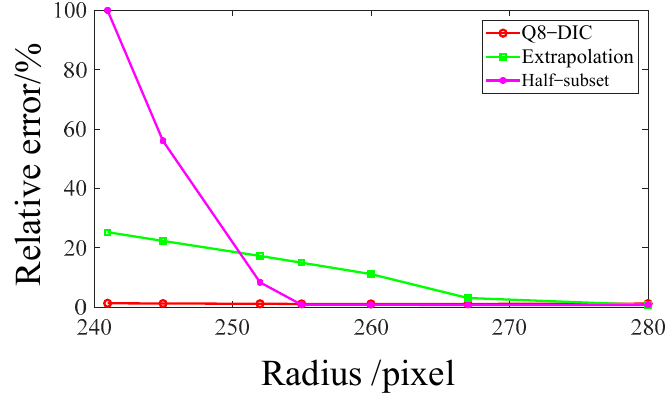
Figure 9. Relative errors along radius at θ = 90 ◦ .